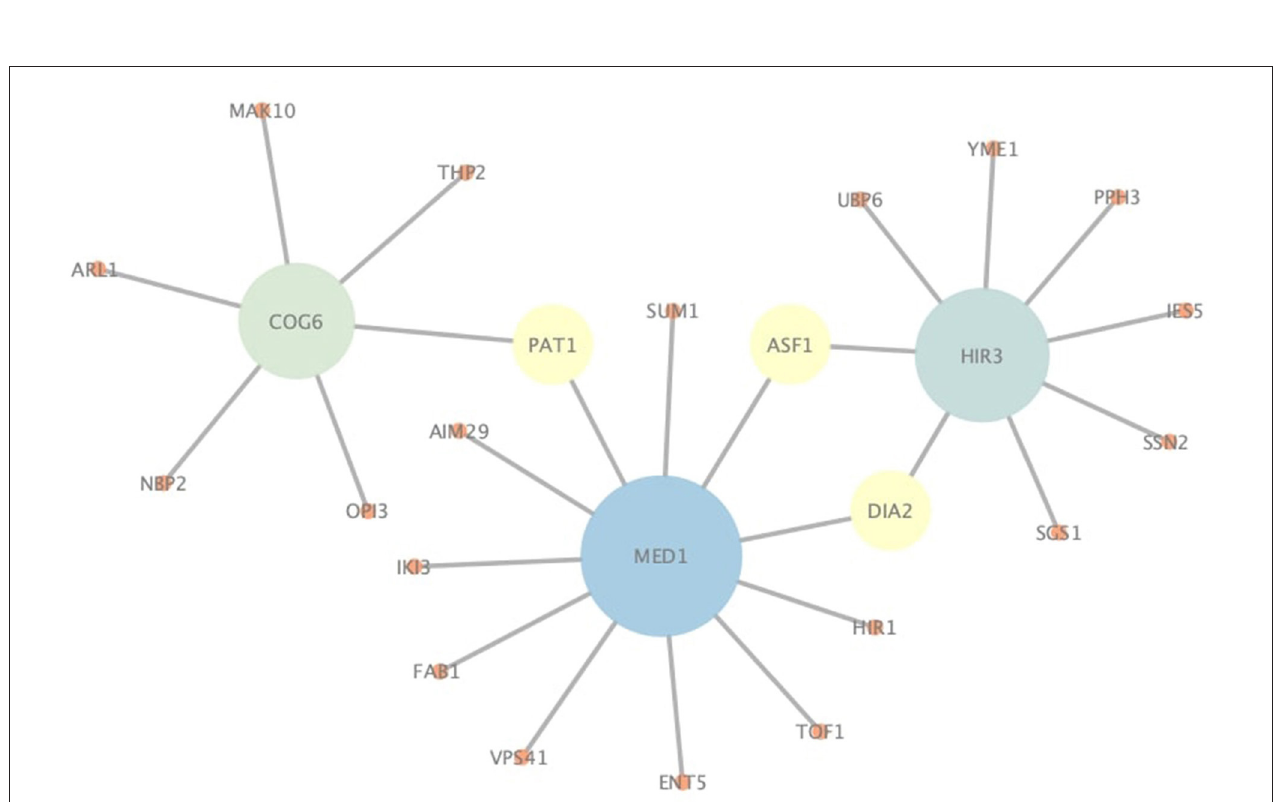
FIGURE 7 | An illustration of novel PPIs identified by NGPM in Yeast-Tong